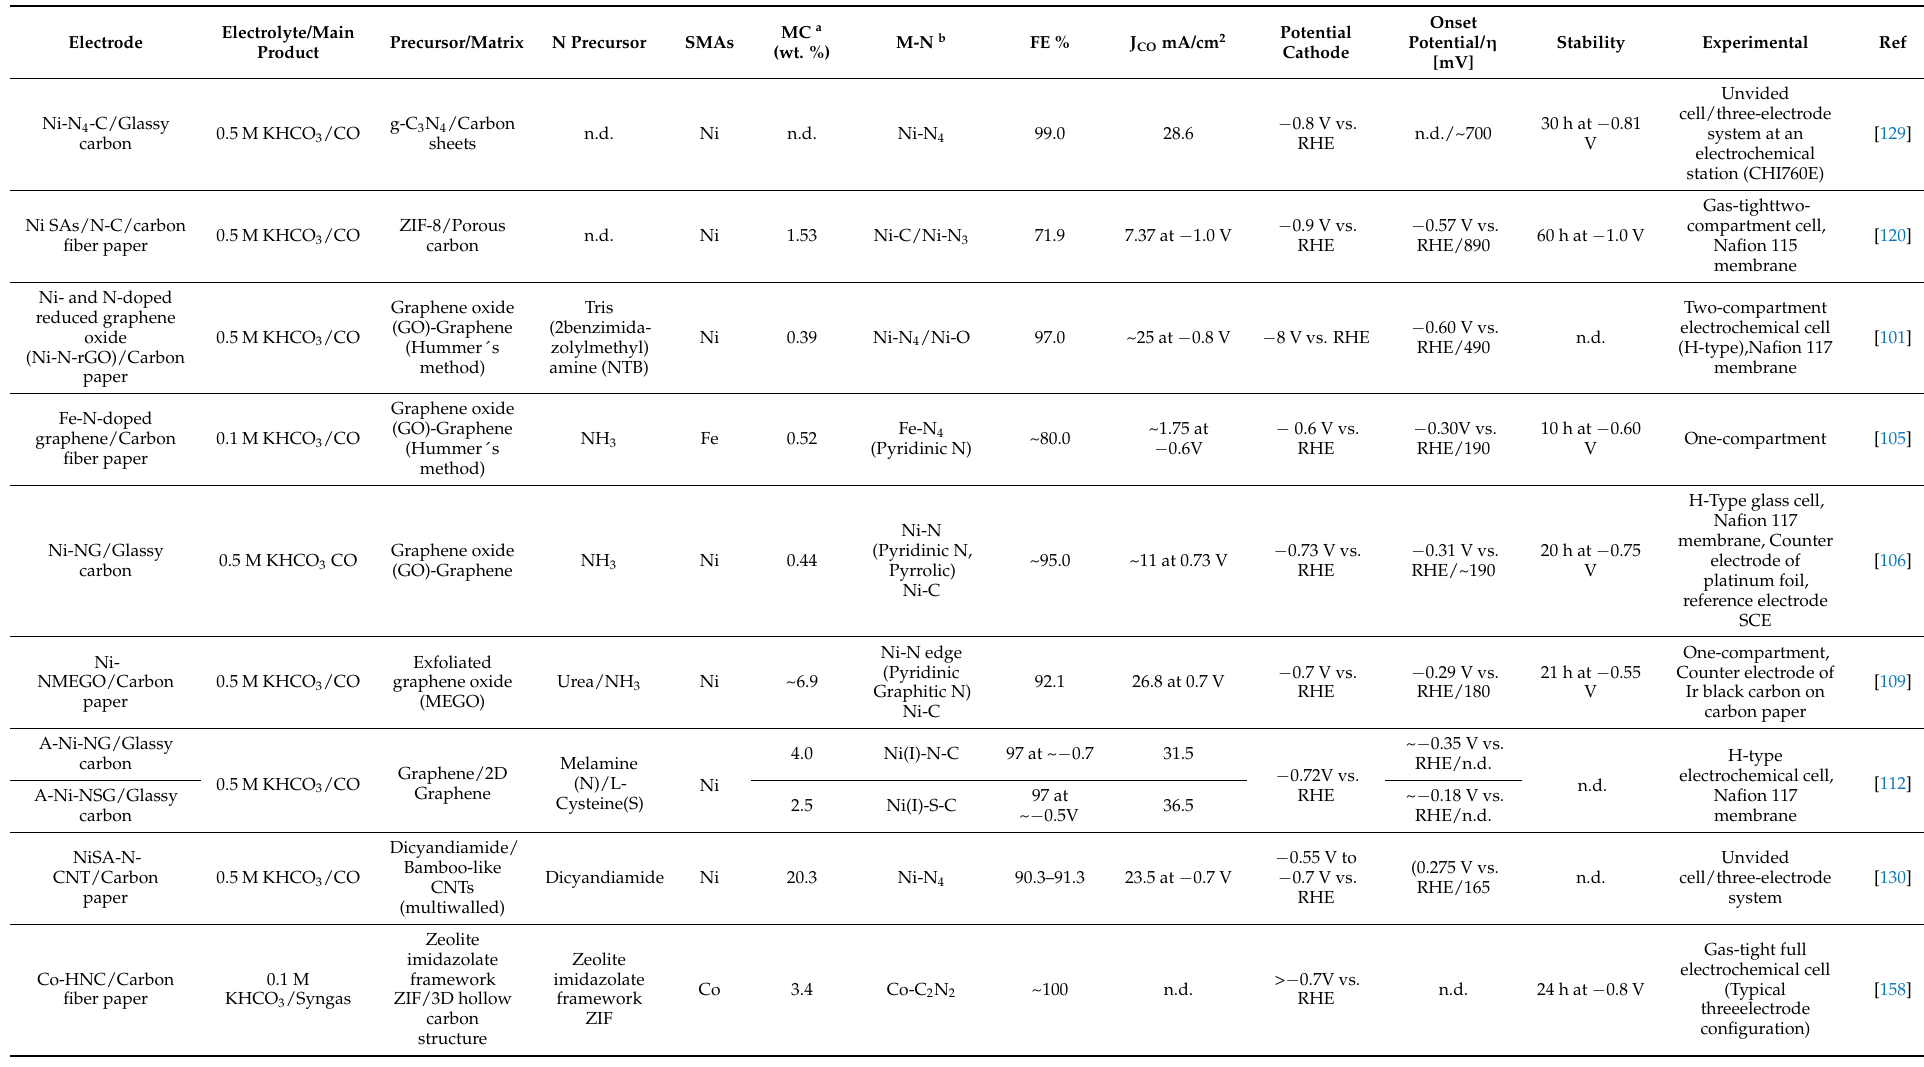
Table 7. Synthesis of single atom catalysts and electrochemical